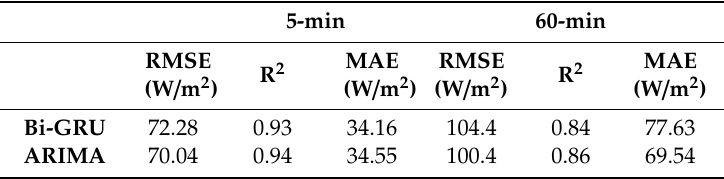
Table 5. Accuracy levels of the ARIMA and Bi-GRU solar irradiance predictions.